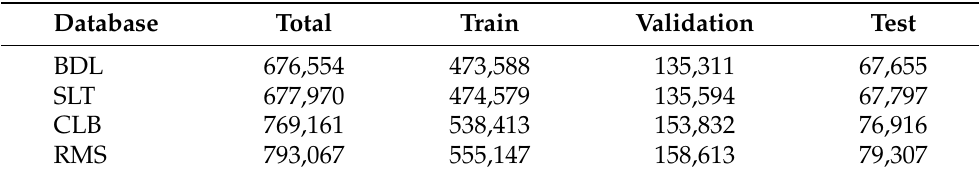
Table 1. Amount of data (vectors) available for each voice in the